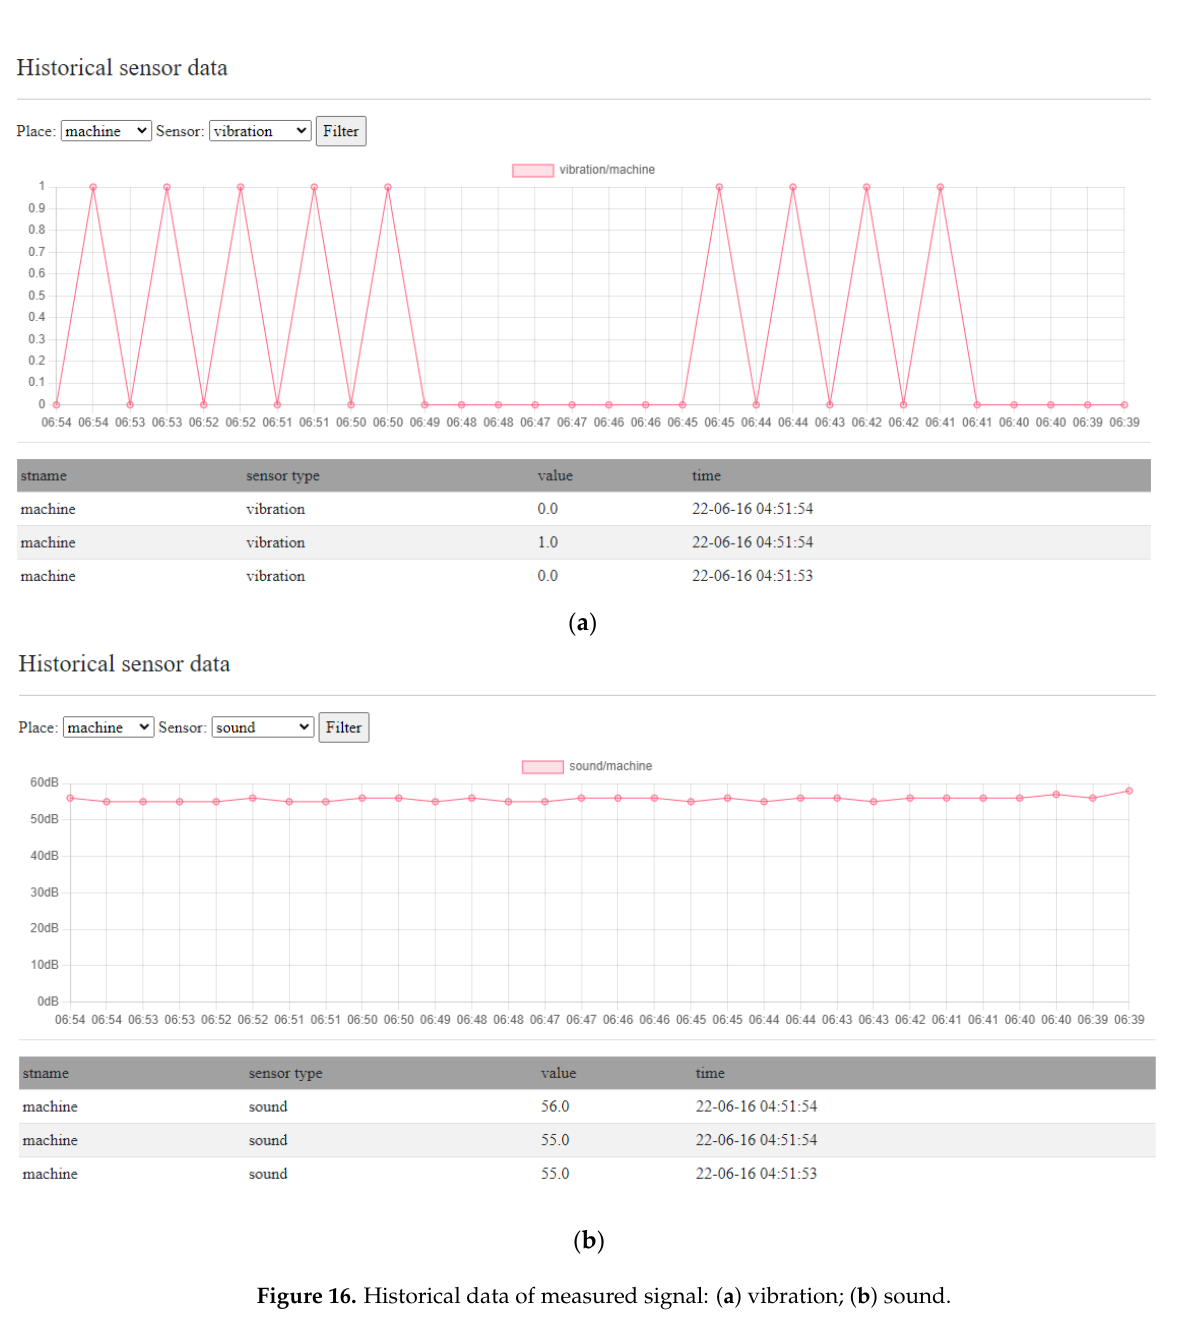
Figure 15. Real-time displays of sensor dashboards on the website.